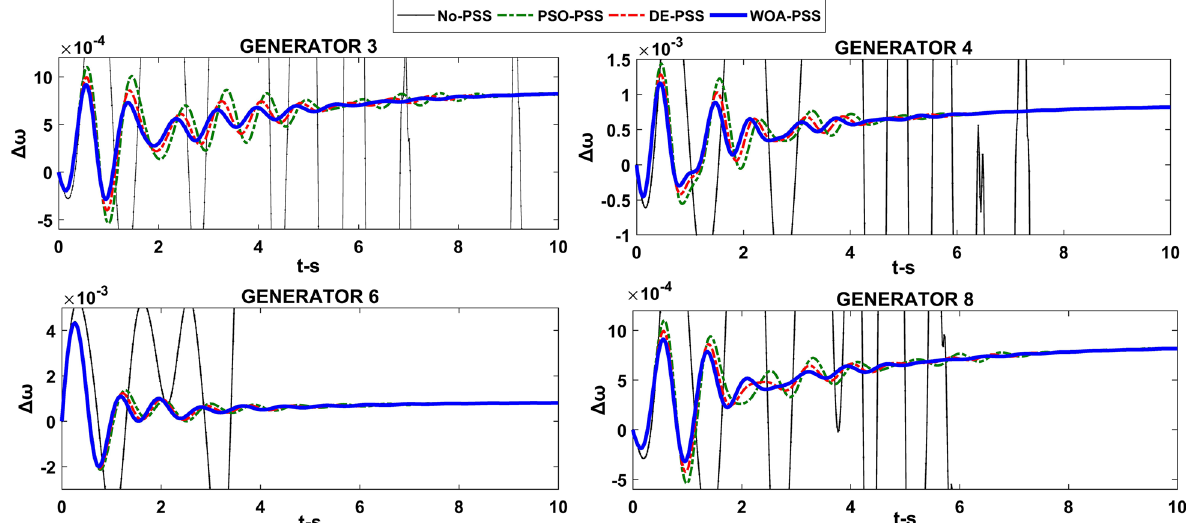
Fig. 12 Speed deviation plots under the disturbance of line outage between 14 and 15